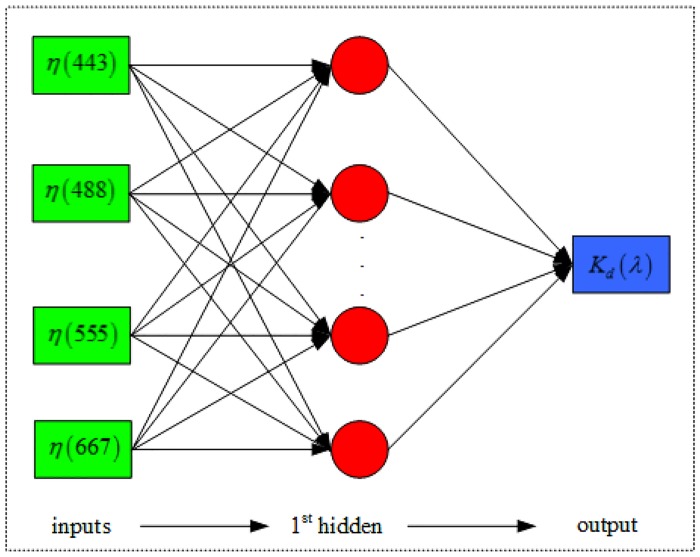
Basic architecture of the NNKM model used in this work.